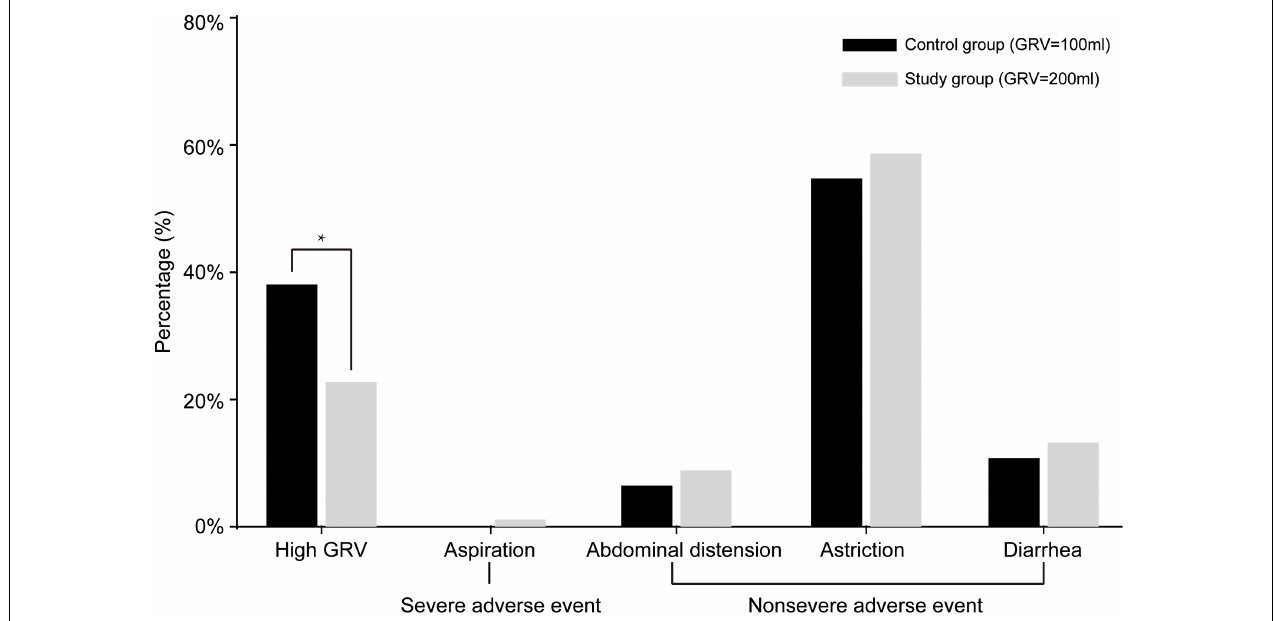
FIGURE 2 | Gastrointestinal complications of patients in the two groups. In the study group, 38 patients (22.8%) had high gastric residual volume (GRV) events, 2 patients (1.2%) had aspiration, 15 patients (8.9%) had abdominal distension, 98 patients (58.7%) had astriction, and 24 (14.4%) had diarrhea. No patients in the control group had severe adverse events (aspiration); in this group, 64 patients (38.1%) had high GRV events, 11 patients (6.5%) had abdominal distension, 92 patients (54.8%) had astriction, and 19 (11.3%) had diarrhea. * P <